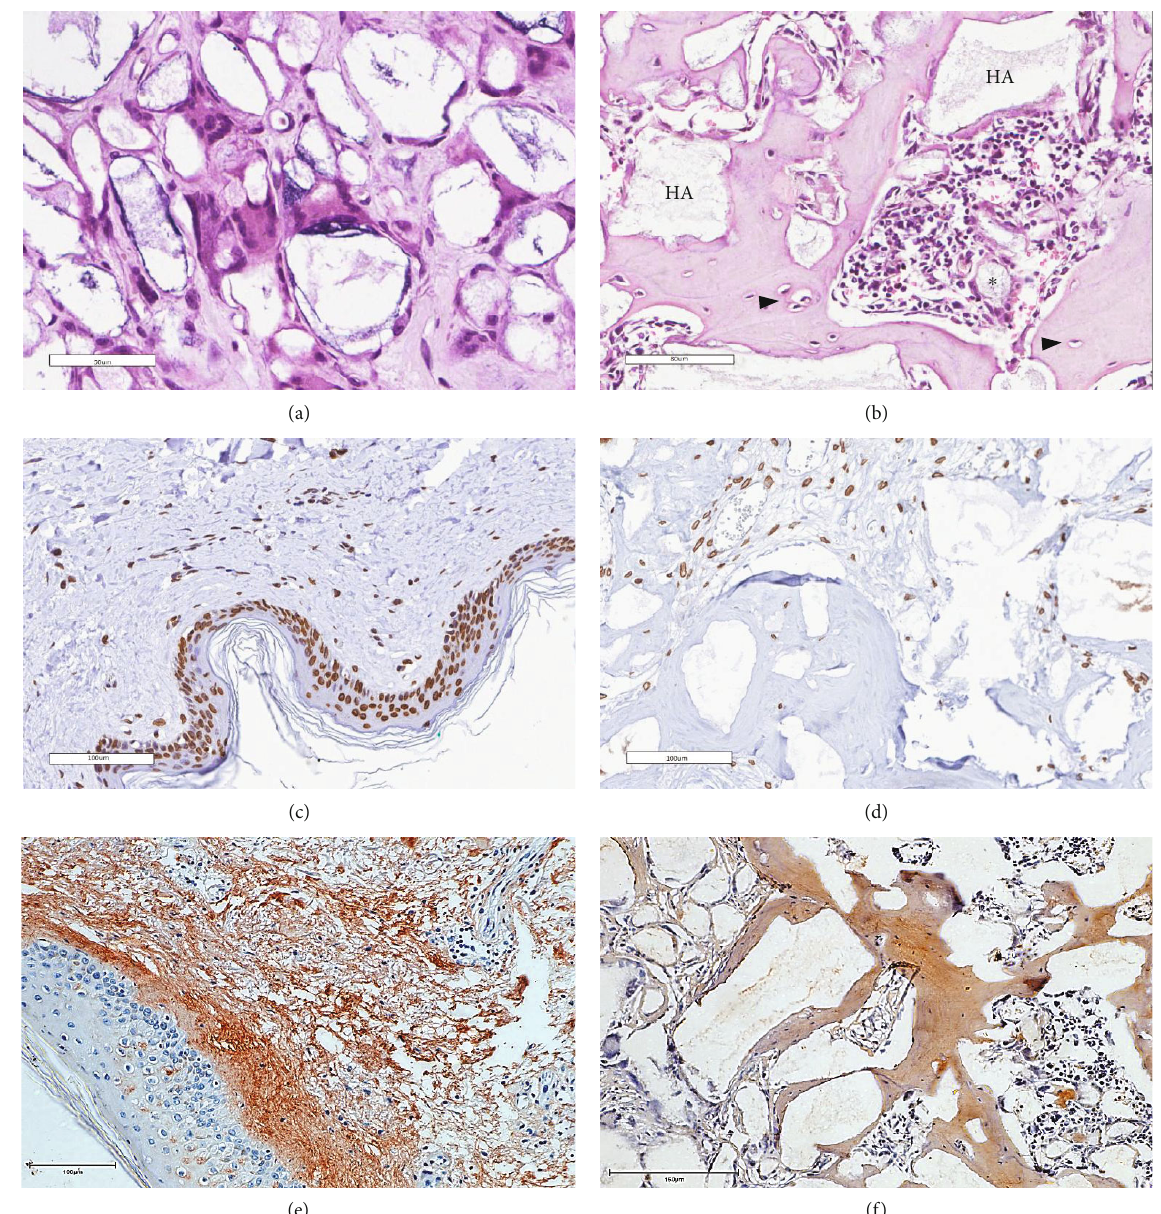
Figure 4: Osteogenic potential of BMSCs in vivo. In vivo transplantation assays were performed by combining BMSCs with HA/TCP followed by subcutaneous transplantation into immunocompromised mice. (a, b) H&E staining. (a) Negative control (HA/TCP transplantation without BMSC). (b) BMSCs formed ectopic ossicles that were sometimes populated by host hematopoietic marrow (asterisk). The arrowheads indicate osteocytes. HA=hydroxyapatite/tricalcium phosphate particles. (c – f) The human origin of the woven bone by immunohistochemical analysis. (c, e) Positive control of lamin A/C and collagen I stains, respectively, in human skin. (d, f) Expression of human lamin A/C and collagen I within the woven bone (for the immunohistochemistry analysis, n = 3